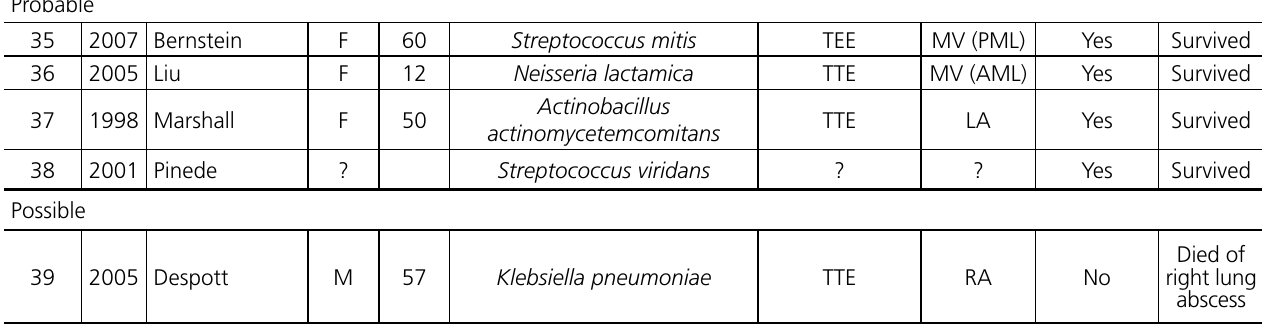
Table 2. Risk factors. Risk factor Present